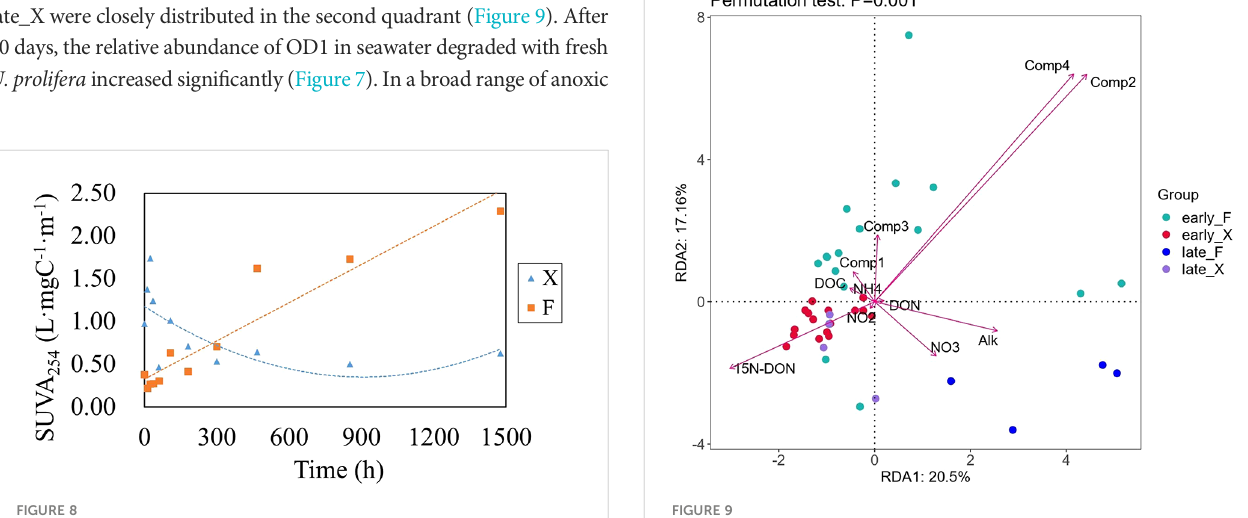
FIGURE 8 Variation in SUVA 254 in water during the degradation of fresh U. prolifera (X) and pre-decomposed U. prolifera (F).